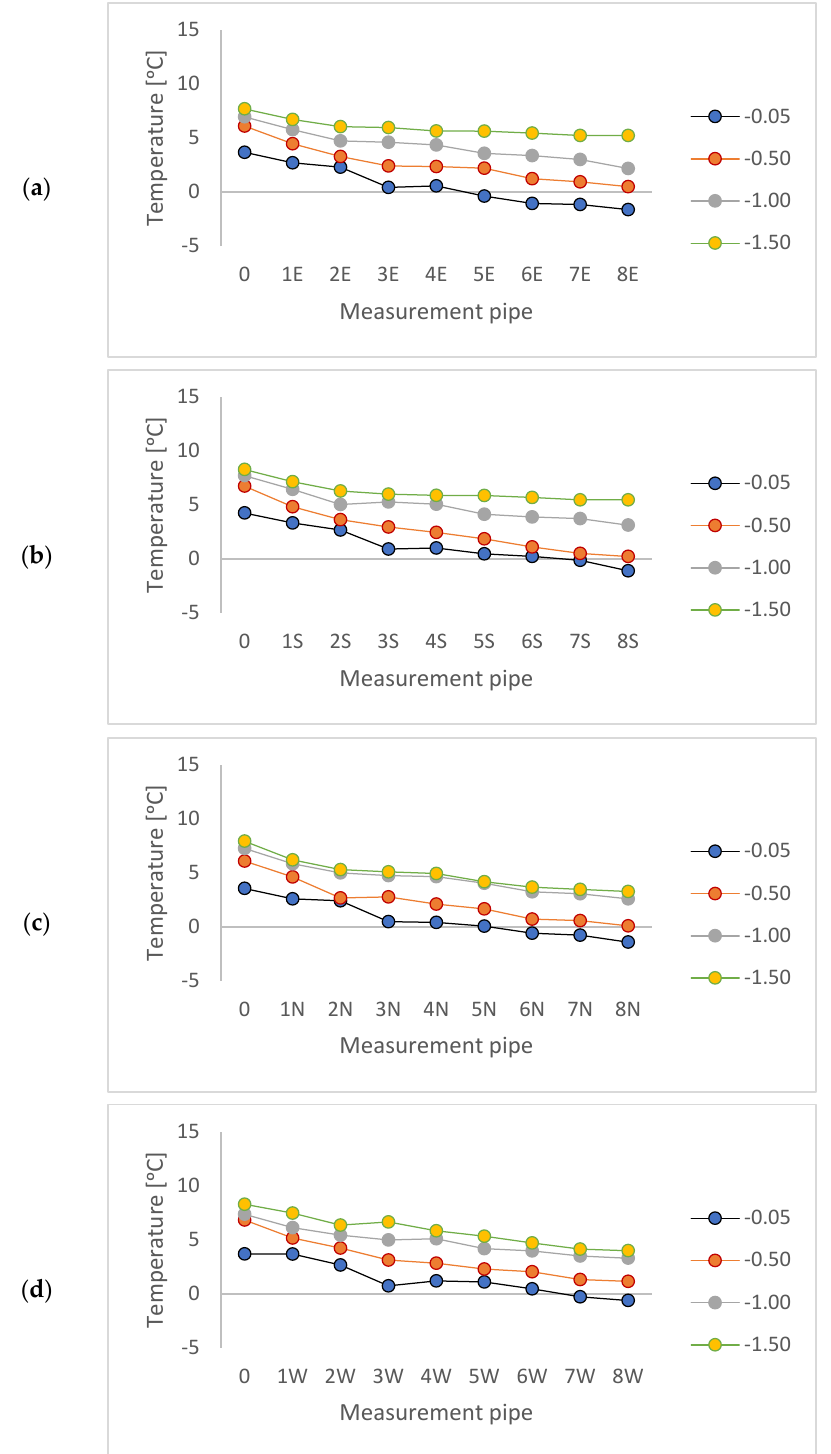
Figure 9. Ground temperature in the studied measurement columns at depths of 0.05 m, 0.50 m, 1.00 m, and 1.50 m to the ( a ) east, ( b ) south, ( c ) north, and ( d ) west. Winter period (January 12, Θ e = − 2.7 °C; Θ i = 0.5 °C).